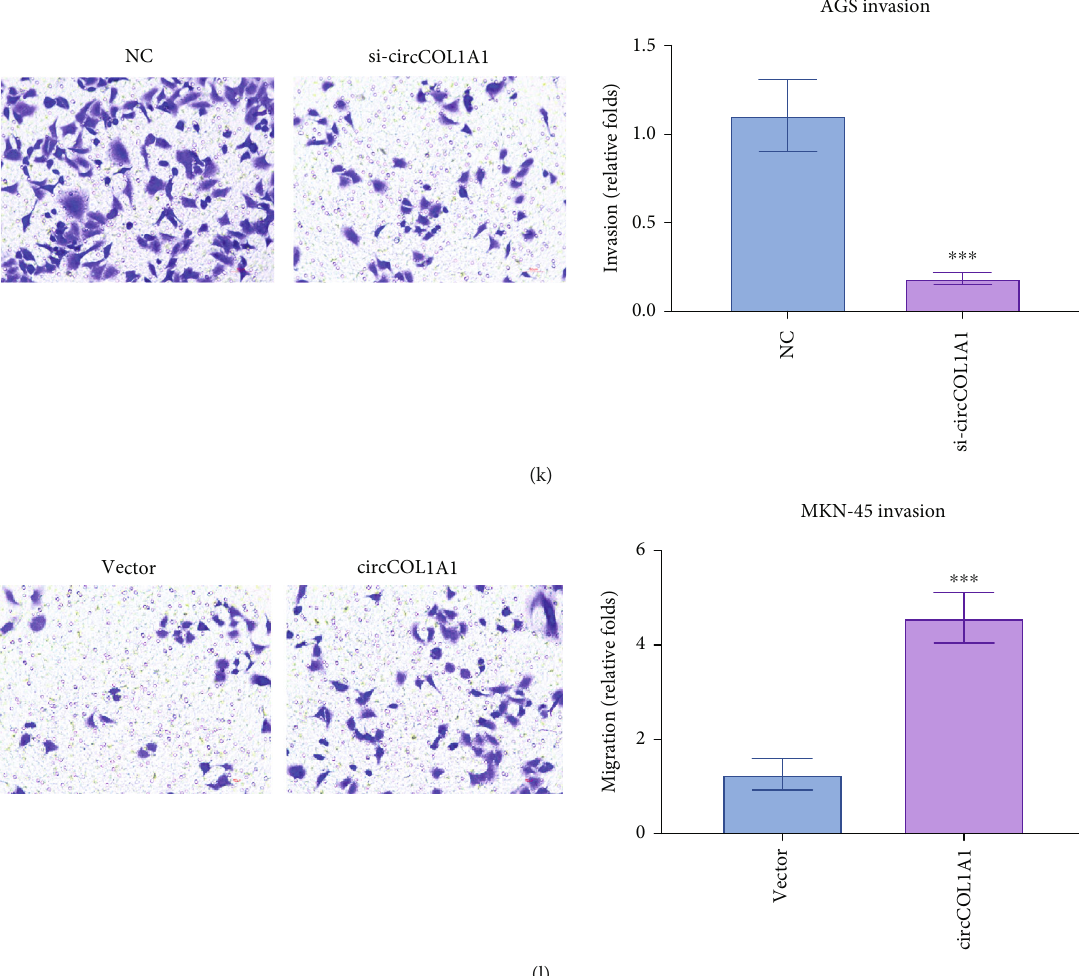
Figure 2: circCOL1A1 promotes the proliferation, migration, and invasion of gastric cancer cells. (a, b) Loss-of-function experiments were performed by transfecting siRNAs targeting circCOL1A1 into AGS and BGS-823 cancer cells. (c, d) Gain-of-function experiments were carried out by transfecting circCOL1A1 expression plasmids in MKN-45 and SGC-7901. (e – h) CCK8 assays were performed to detect the in fl uence of circCOL1A1 on proliferation in gastric cancer cells. (i) Migration assays were performed to detect the in fl uence of circCOL1A1 silence on AGS migration. (j) Migration assays were performed to detect the in fl uence of circCOL1A1 overexpression on MKN-45 migration. (k) Invasion assays were performed to detect the in fl uence of circCOL1A1 silence on AGS invasion. (l) Invasion assays were performed to detect the in fl uence of circCOL1A1 overexpression on MKN-45